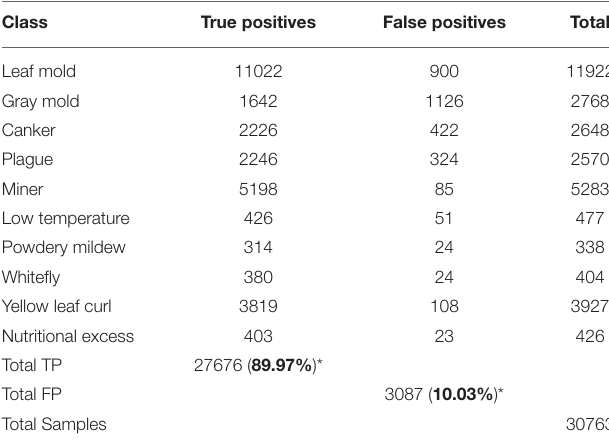
Frontiers in Plant Science |